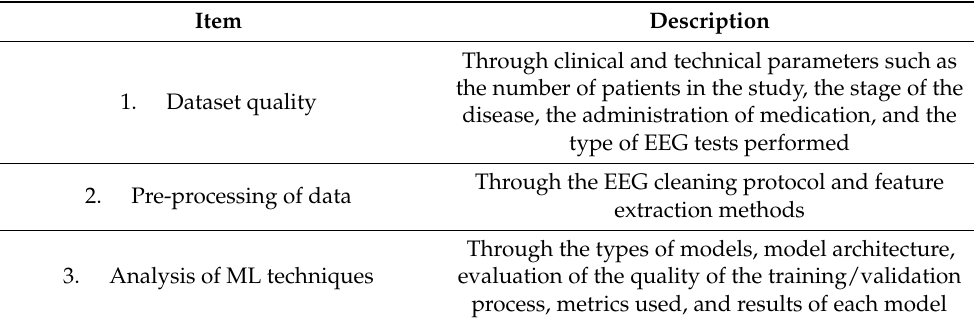
Table 2. Description of the items considered for the analysis of the